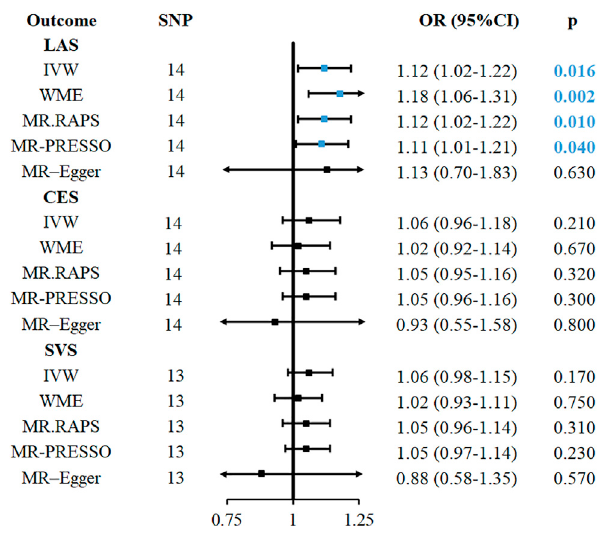
FIGURE 3 | MR analyses causal effect estimates for associations between childhood obesity with IS and its subtypes. CI, con fi dence